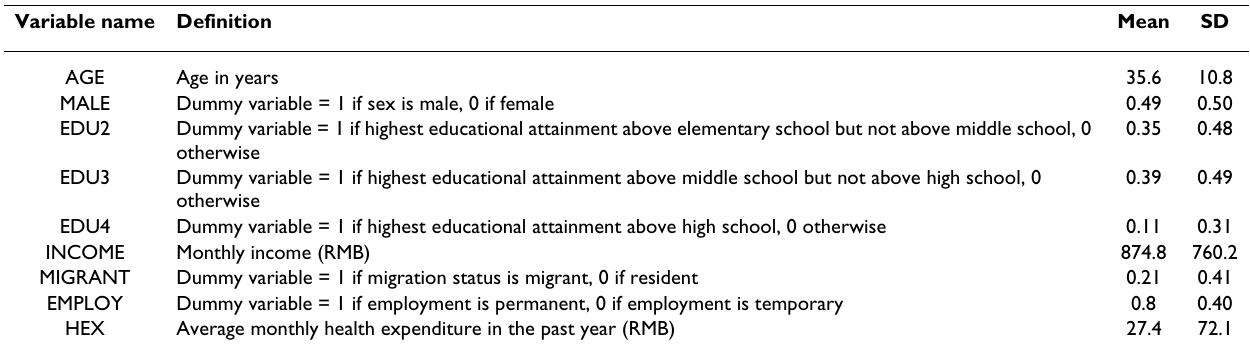
Table 1: Independent variables (N =